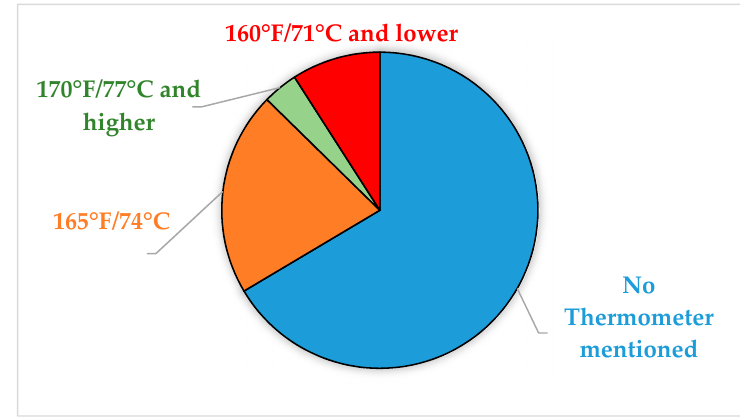
Figure 3. Temperature information provided by recipes in this study (%).